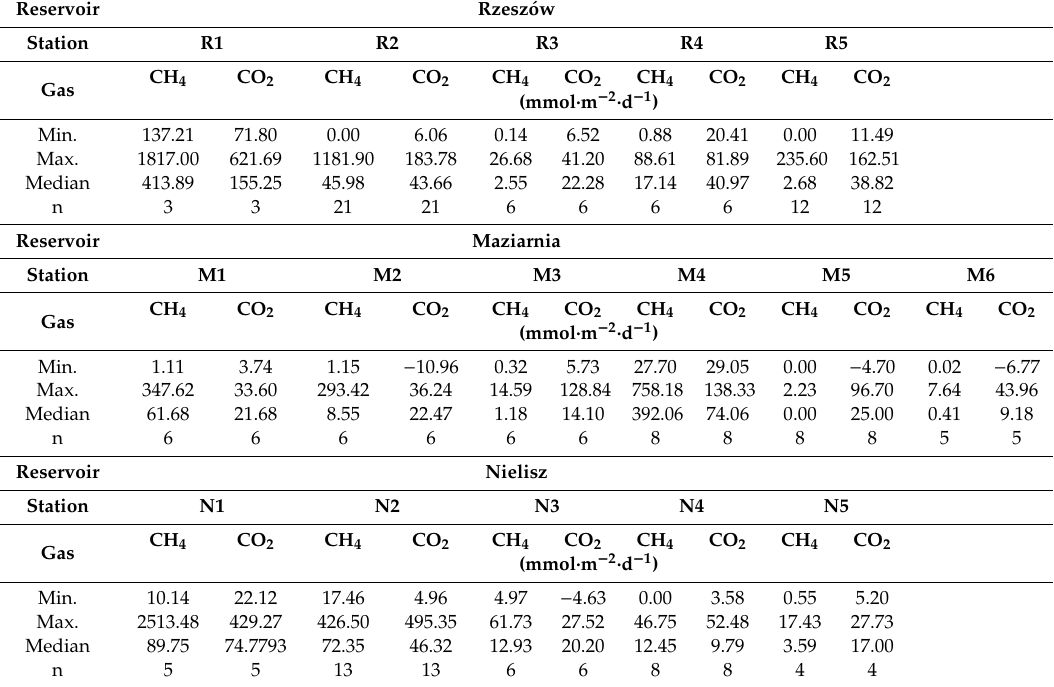
Table 2. Minimum, maximum and mean values for fluxes of CH 4 and CO 2 at the water–air interface; n —number of